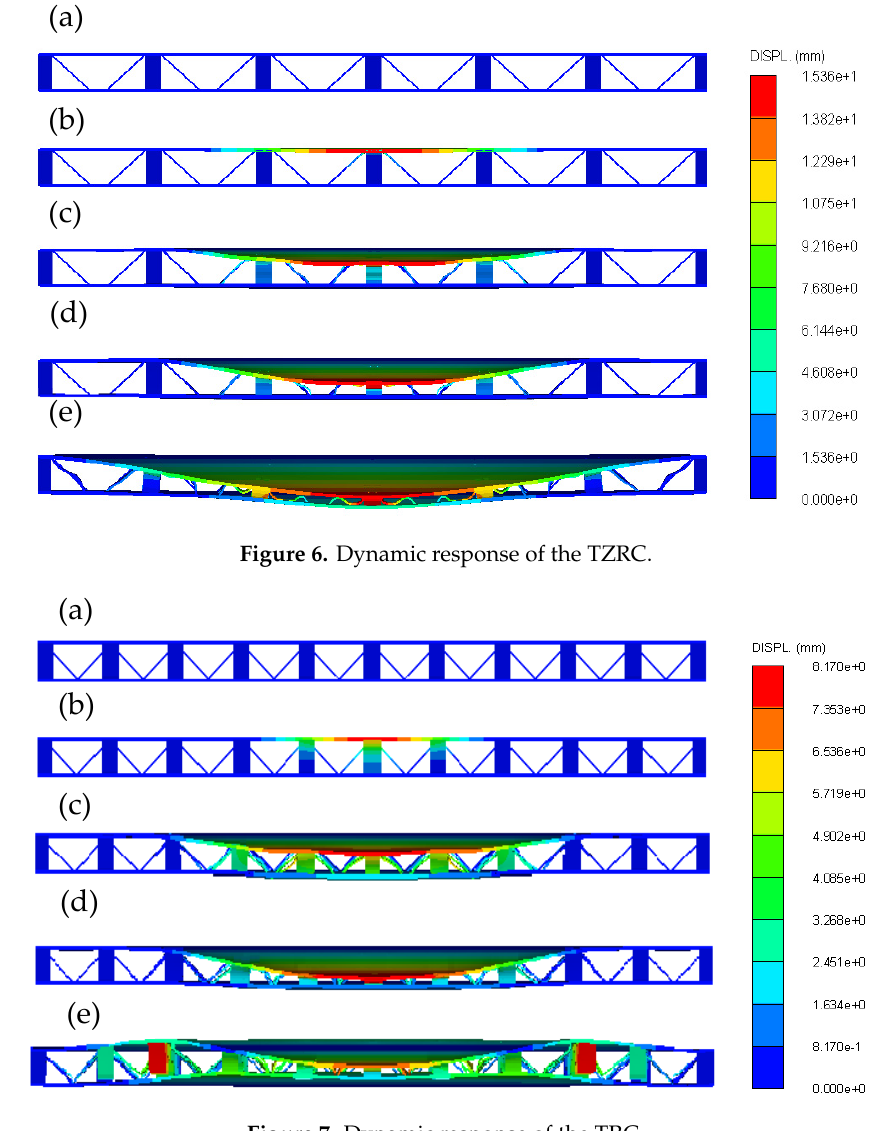
Figure 7. Dynamic response of the TRC.